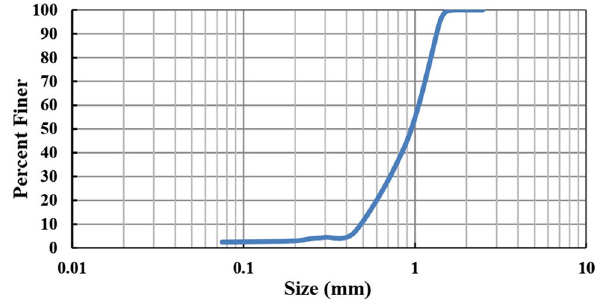
Fig. 3 Grading diagram of sediments